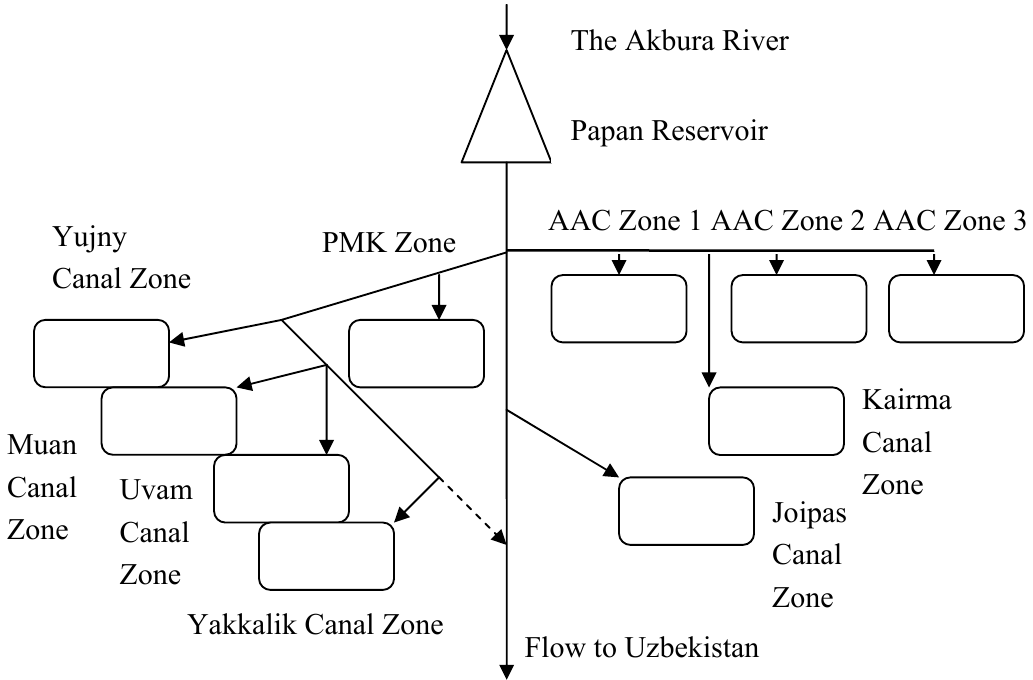
Figure 3. Simplified diagram of water distribution in the Akbura River basin.